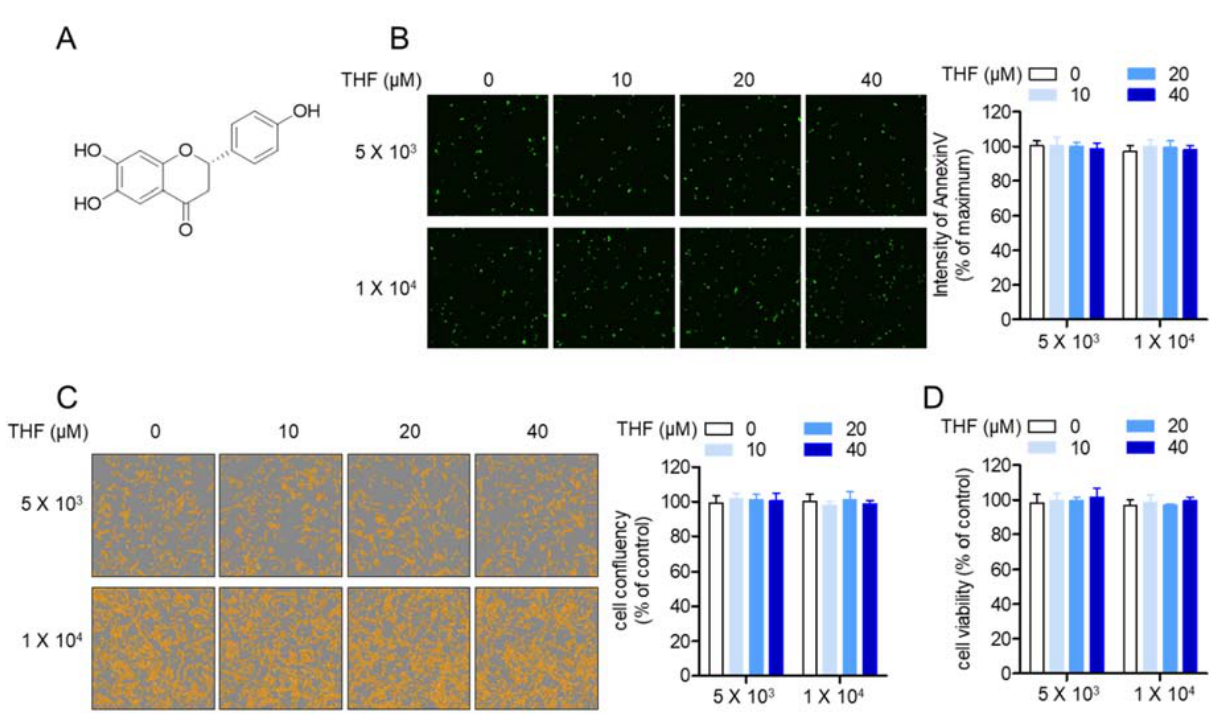
Figure 1. ( A ) The chemical structure of 6,7,4 ′ -trihydroxyflavanone (THF). ( B – D ) SH-SY5y cells (5 × 10 3 /well (top) or 1 × 10 4 /well (bottom), 96-well plate) were stained with 1× annexin V and 1× caspase 3/7 staining reagent and then incubated with the indicated concentrations of THF for 24 h. After incubation, the intensity of annexin V ( B ) and cell confluency ( C ) was determined using the IncuCyte imaging system. For the measurement of cell viability, the MTT assay was conducted and the percentage of the control was calculated based on the resulting OD value ( D ). Results are shown as the mean value of three experiments ± SEM.